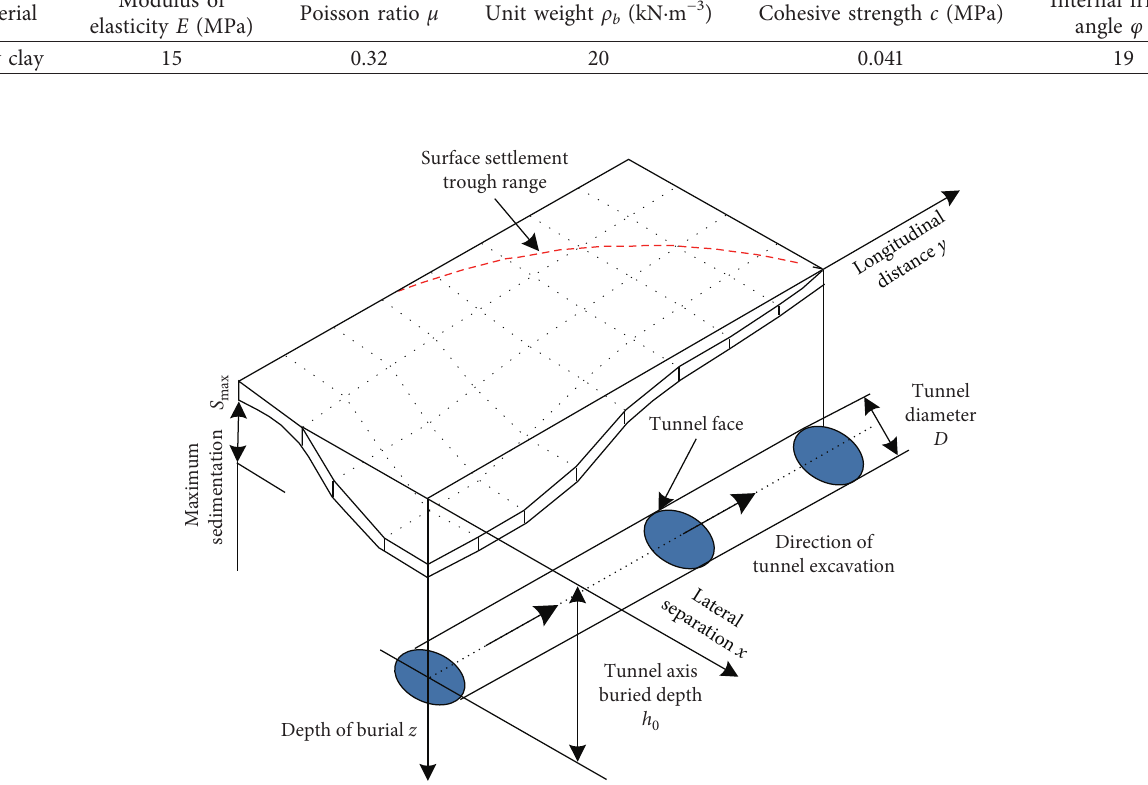
Figure 9: Three-dimensional surface sedimentation tank